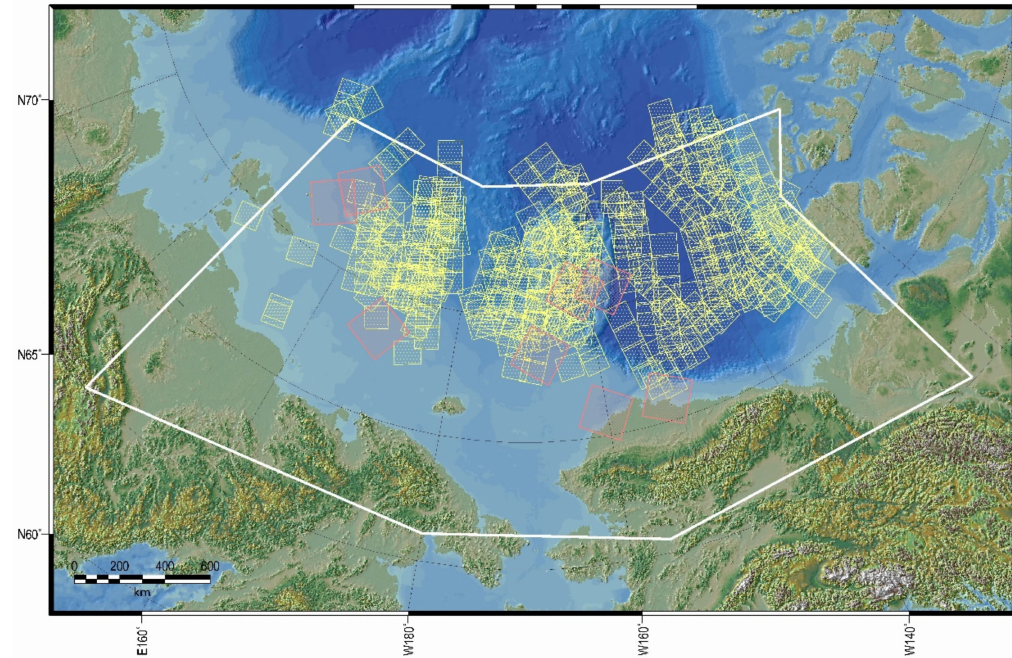
Figure 1. A map of the East Siberian Sea, Chukchi Sea, and Beaufort Sea (the Pacific Arctic Ocean). Yellow and red boxes represent the coverages of KOMPSAT-5 EW SAR and Landsat-8 OLI images used in this study. The white polygon represents the area of the Pacific Arctic Ocean defined by Meier et al.